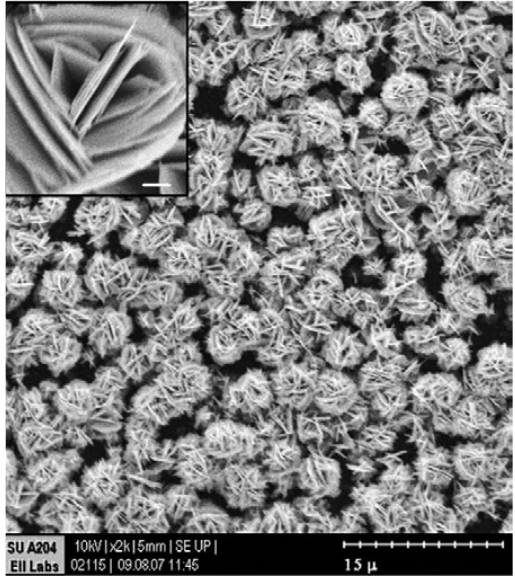
Fig. 9: Silver flowerlike nanostructures grown on a flat Al substrate. Reproduced with permission from ref.41, copyright 2008,